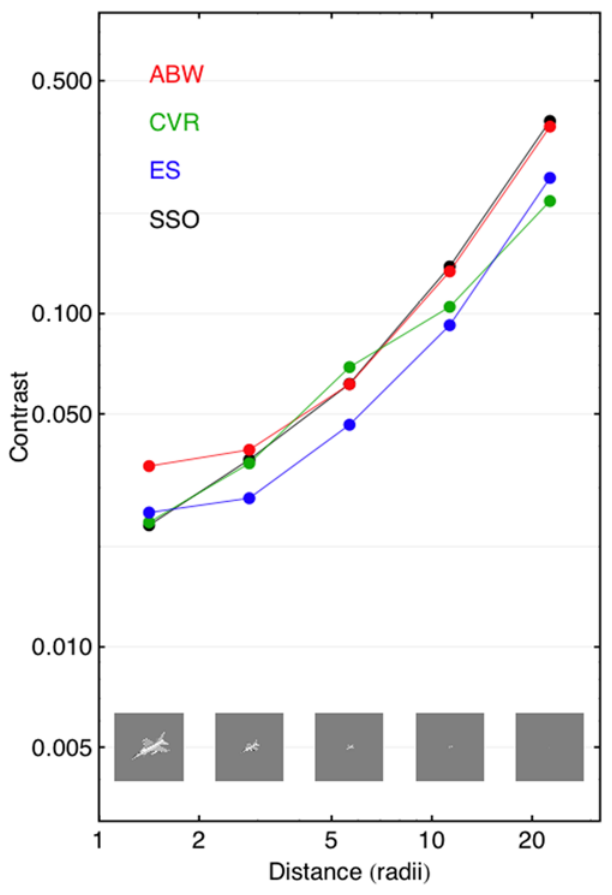
Figure 10. Contrast thresholds for aircraft targets varying in size. Results from three observers and predictions of the SSO are shown. Actual aircraft images are shown in the figure.